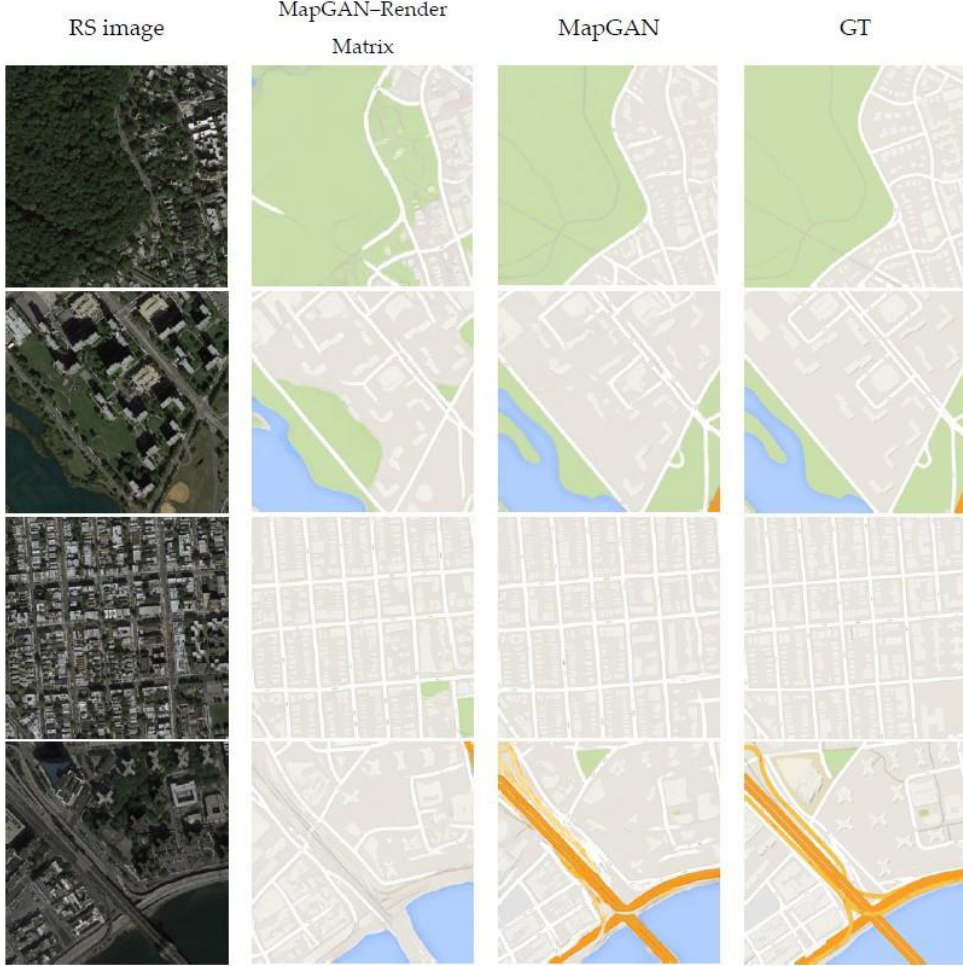
Figure 10. Comparison results of the map generated by MapGAN before and after the removal of the render matrix in the one-to-one map generation experiment. The images from left to right are remote sensing images, the Google maps generated by MapGAN without using render matrix, the Google maps generated by MapGAN, and the real Google maps.